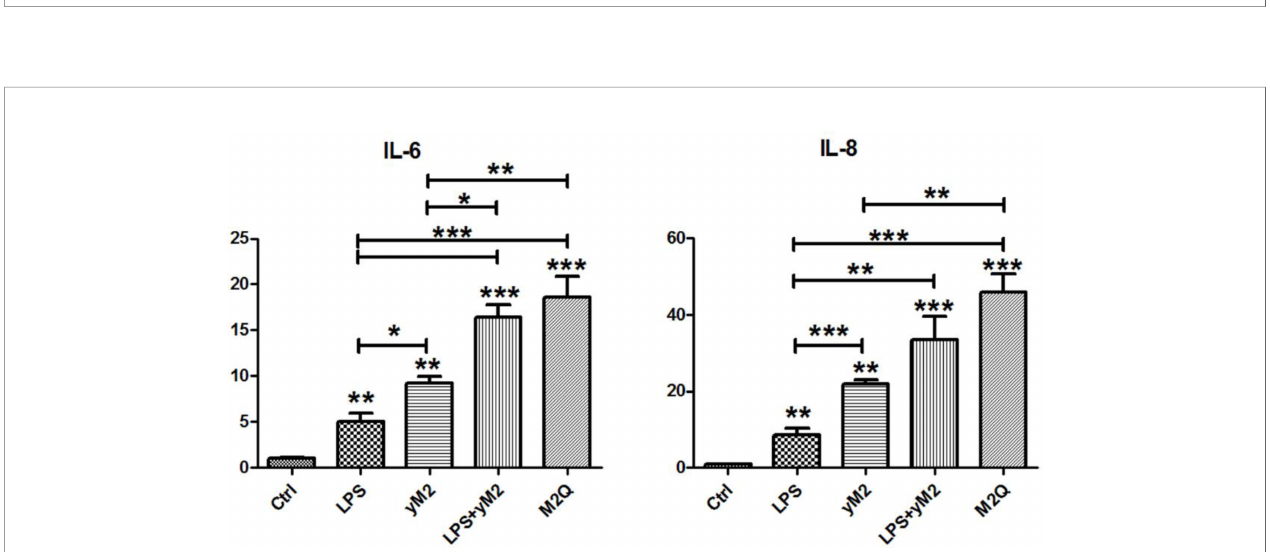
FIGURE 4 | The effect of recombinant Der m 2 protein on IL-6 and IL-8 mRNA expression in human BEAS-2B cells. The puri fi ed recombinant Der m 2 ( fi nal 1 m g/ ml) was added into the cell culture for 4 h of treatment, M2Q from E. coli and yM2 from yeast. The fi nal concentration of LPS (0.8 ng/ml) that was equal to the endogenous LPS in M2Q was added into the cell culture for the same condition. Control was incubated for the same condition without adding anything. The total RNAs from cells were isolated by Tri reagent and reverse transcribed to cDNA before qPCR by speci fi c primers. All assays were representative of at least three independent experiments performed in duplicate. *** P < 0.001, ** P < 0.01, and * P < 0.05 compared with control or indicated